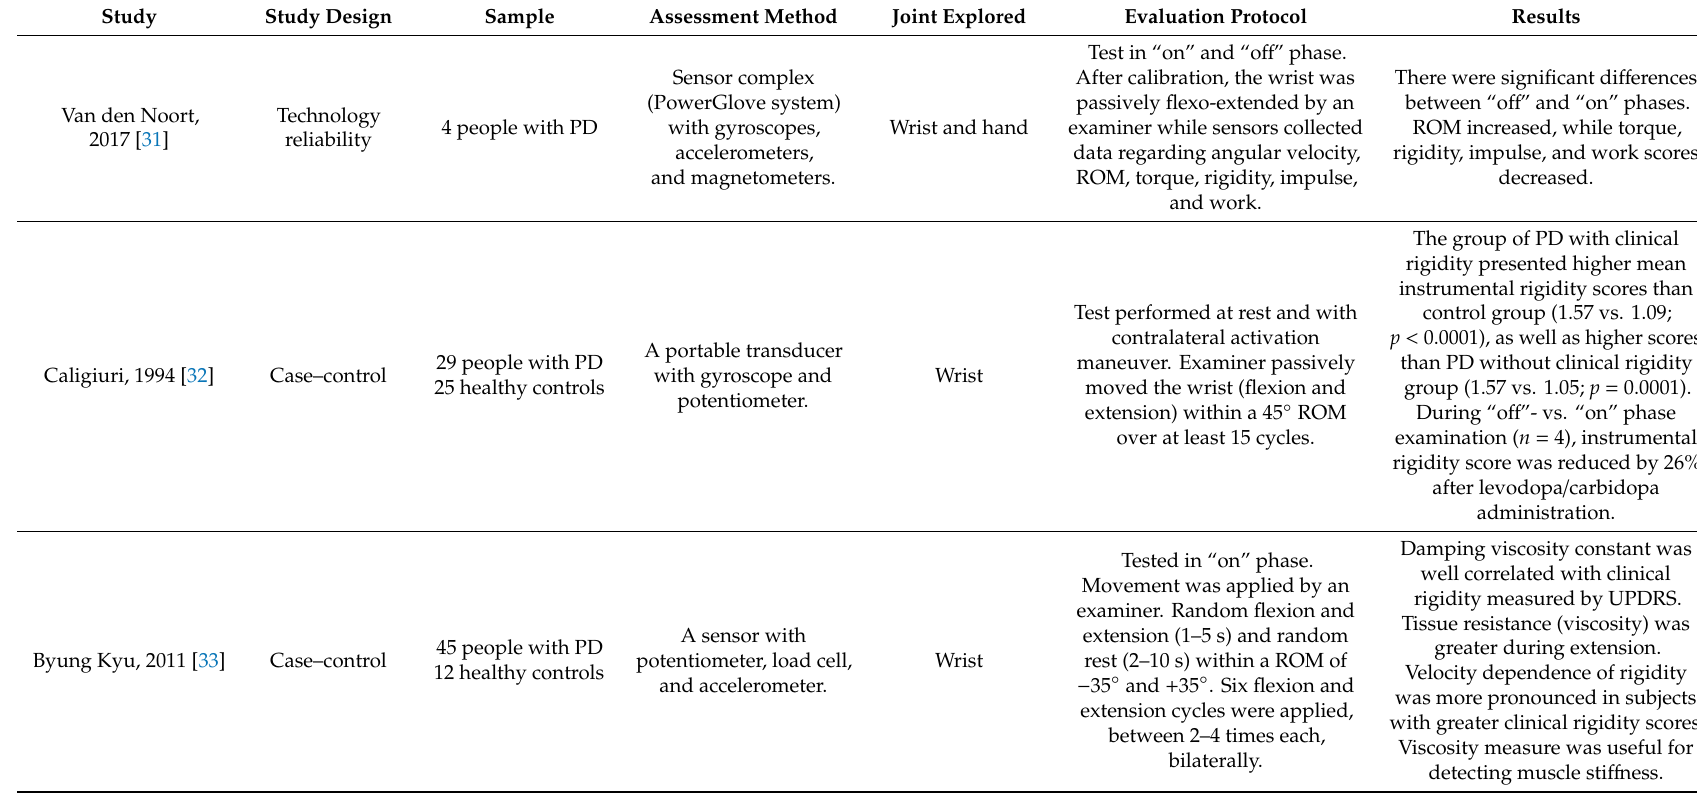
Table 3. Methods using sensors for the capture and analysis of the